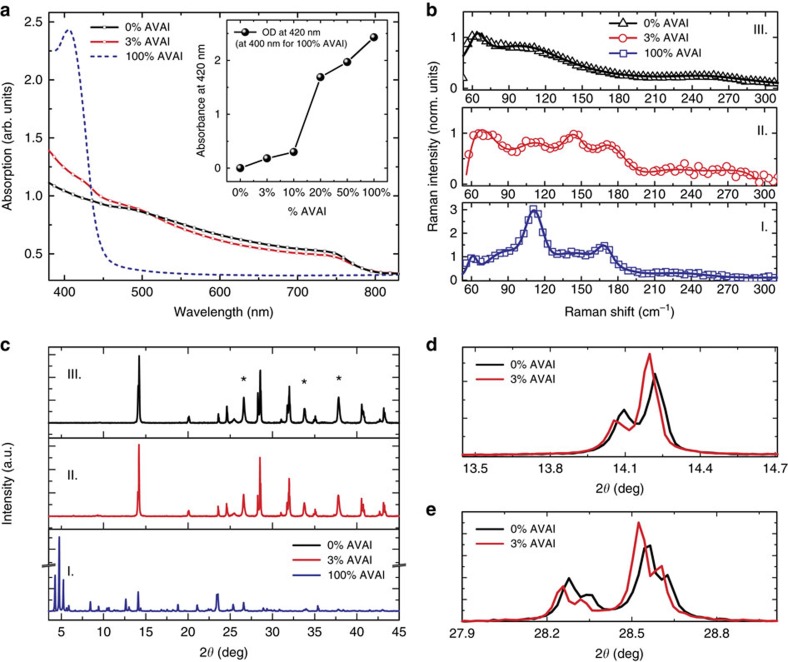
Optical and Structural characterization.(a) Absorption spectra of the (HOOC(CH2)4NH3)2PbI4 (blue dashed line), 3D CH3NH3PbI3 (black line) and 2D/3D (red line) using 3% of HOOC(CH2)4NH3I, AVAI hereafter. In the inset the intensity of the peak at 420 nm with increasing the percentage of AVAI to PbI2. (b) Raman spectra for 100%AVAI (panel I.), 3%AVAI (panel II) and 0%AVAI (panel III) perovskites. Solid lines represent the fit from multi-gaussian peaks fitting procedure (Supplementary Fig. 3 for details). For 3D perovskite main peak at: 78, 109 and 250 cm−1; for 2D at: 73, 109, 143, 171 cm−1 and for 2D/3D at: 62, 87, 112, 143, 169 cm−1; (c) X-Ray diffraction pattern of 100%AVAI (panel I); 3%AVAI (panel II) and 0%AVAI (panel III) perovskite. Peaks denoted with a star originate from the FTO/TiO2 substrate. (d) Zoom of the X-ray diffraction pattern comparing the 3%AVAI with the pure 0%AVAI perovskites at selected angles. Substrate: mesoporous TiO2.